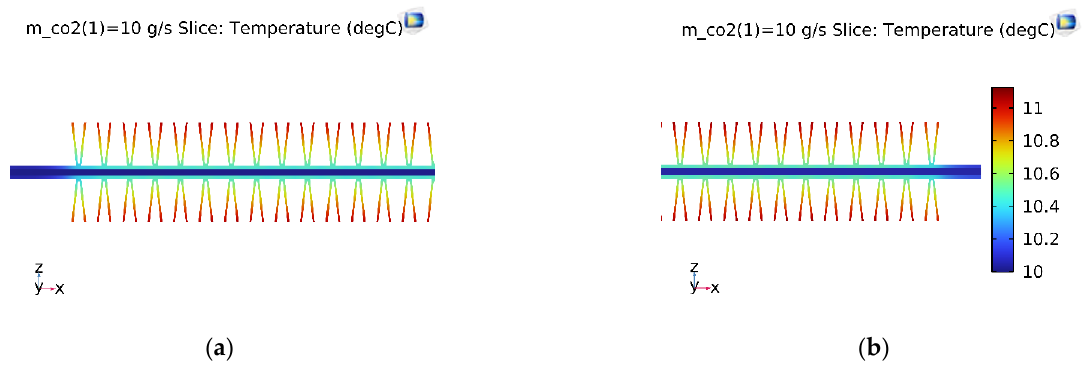
Figure 8. The temperature slice of the V-finned flat tube in the first pass. ( a ) Inlet; ( b ) Outlet.